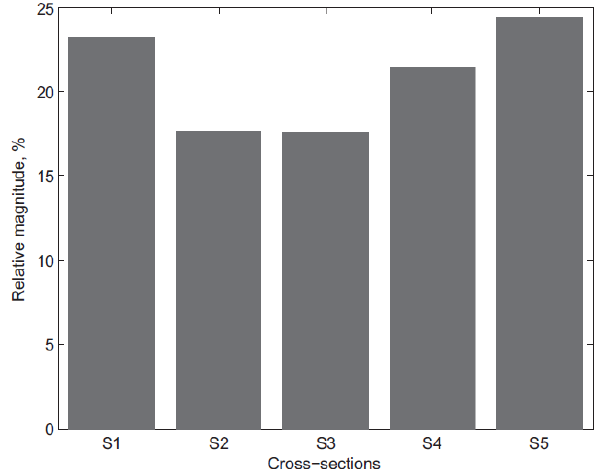
Figure 8: Distribution of duration per year 2009 for different types of flows in the sections 2 Fig. 8. Distribution of duration per year 2009 for different types of displayed in Fig. 1. 3 flows in the sections displayed in Fig. 1.